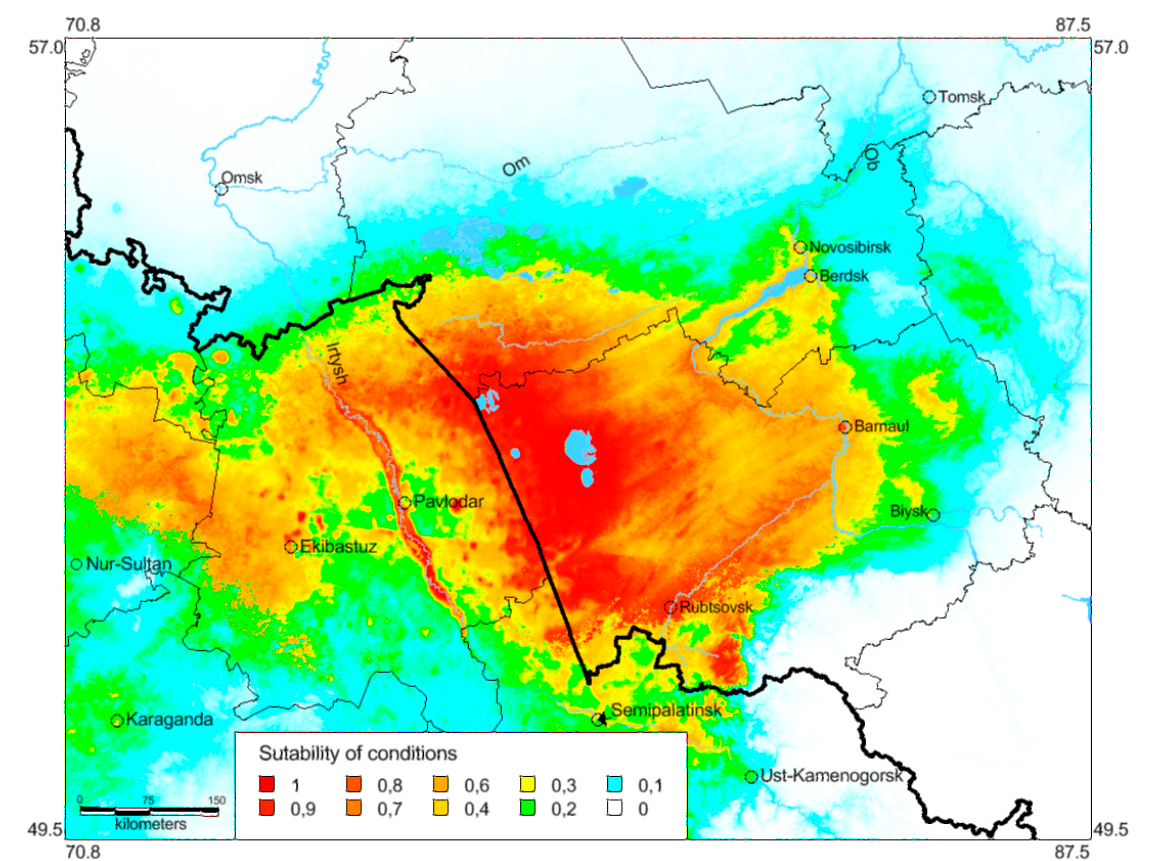
Figure 8. Predicted probabilities of suitable conditions for Oedaleus decorus in the south-eastern part of the West Siberian Plain (distribution data from 1961 until 2021 and bioclimatic variables for 1970–2000; point-wise mean for 20 replicates).